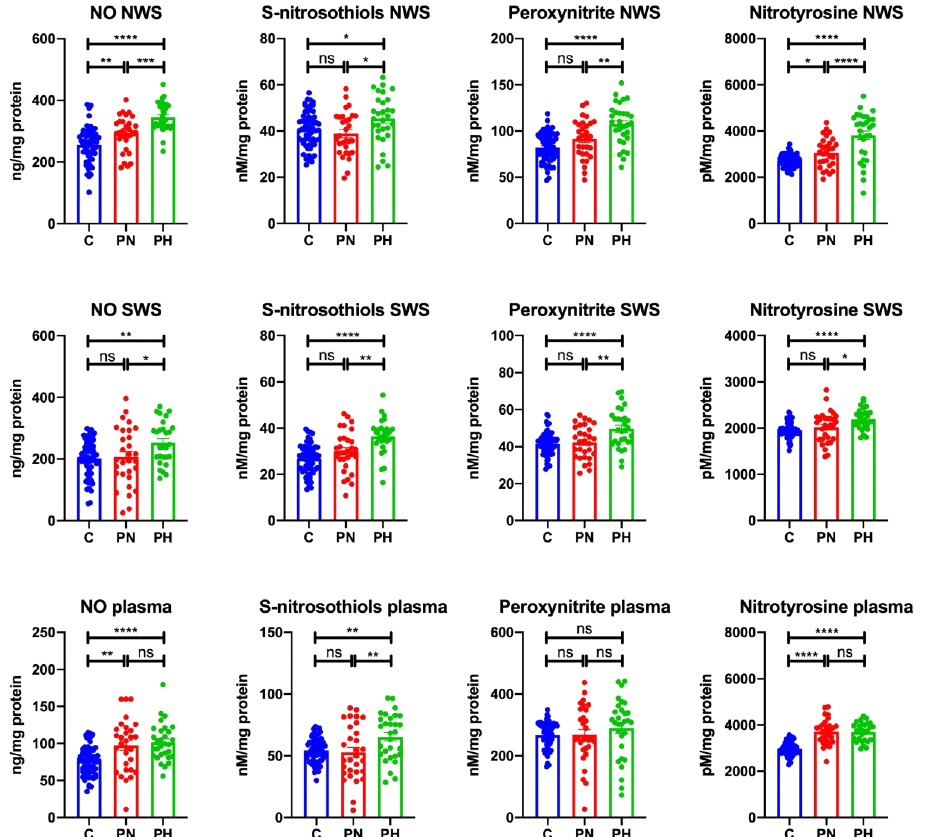
Figure 2. Nitrosative stress in non-stimulated and stimulated saliva as well as plasma of plaque psoriasis patients with normal salivation and hyposalivation. Abbreviations: C — the control; NO — nitric